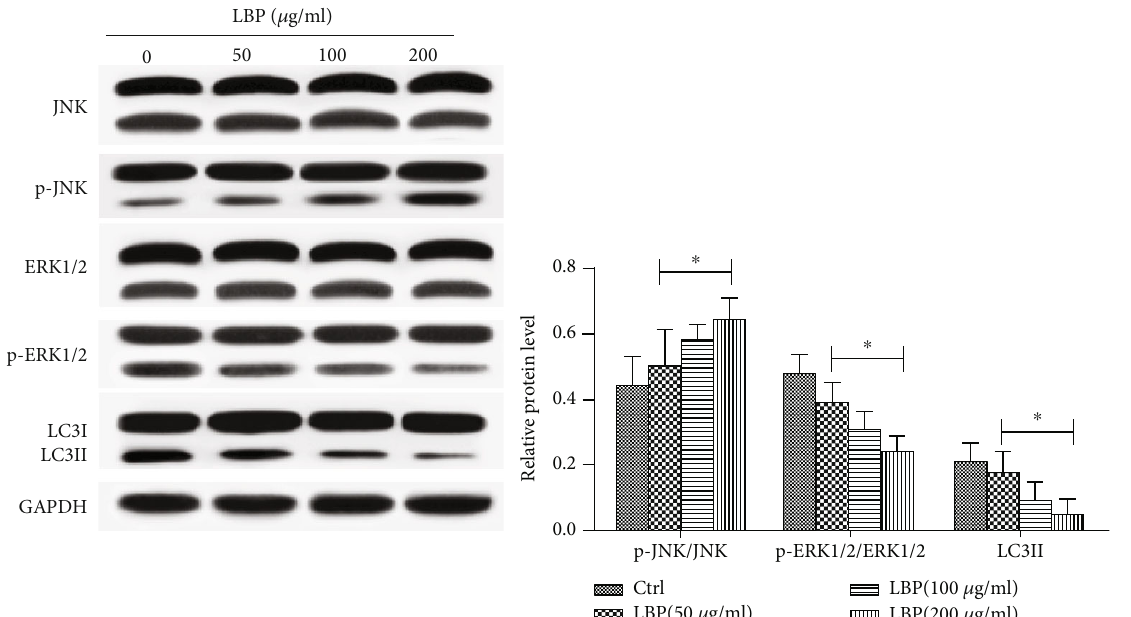
Figure 4: E ff ect of LBP on expression levels of autophagy markers and signaling pathway proteins in A431 cells. Compared with the control group, ∗ P < 0 : 01